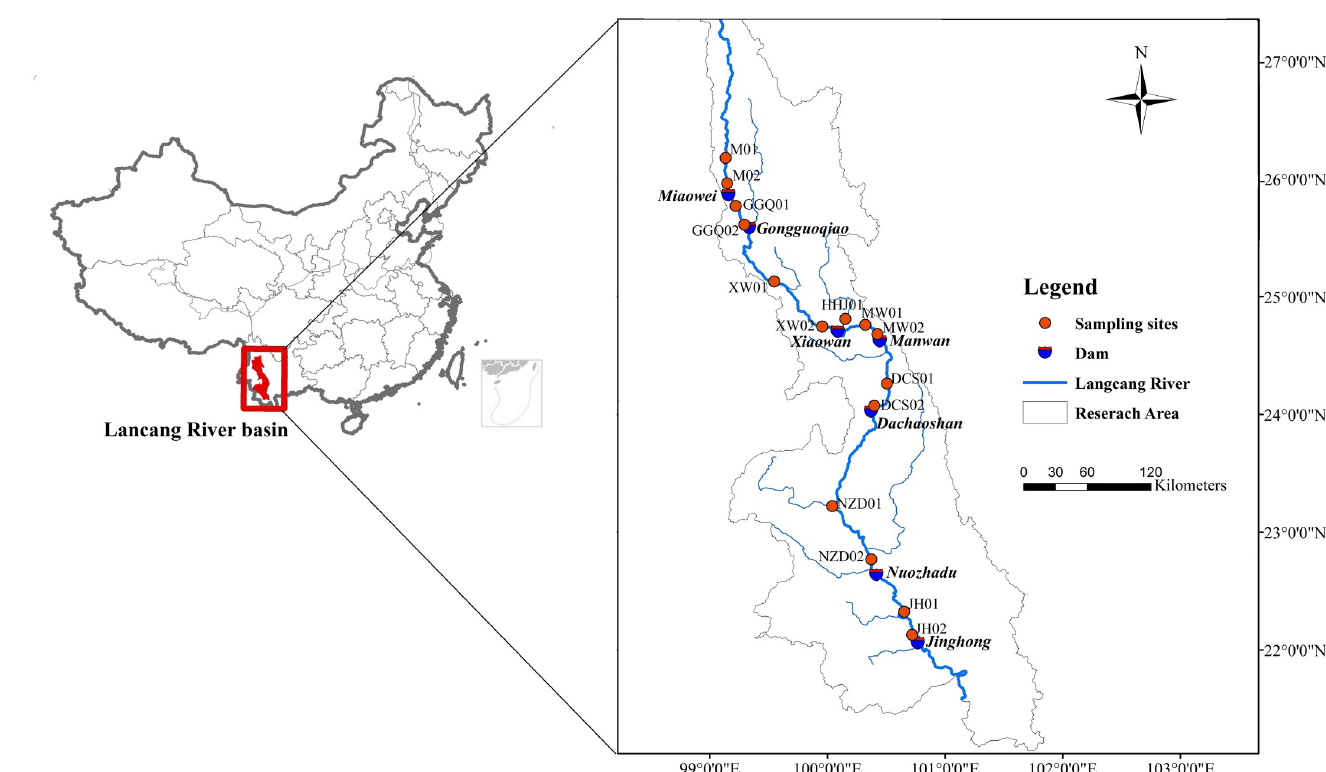
Fig 1. Study area and sampling sites in LRCR (the base map for this figure originated from NASA earth observatory (public domain)).